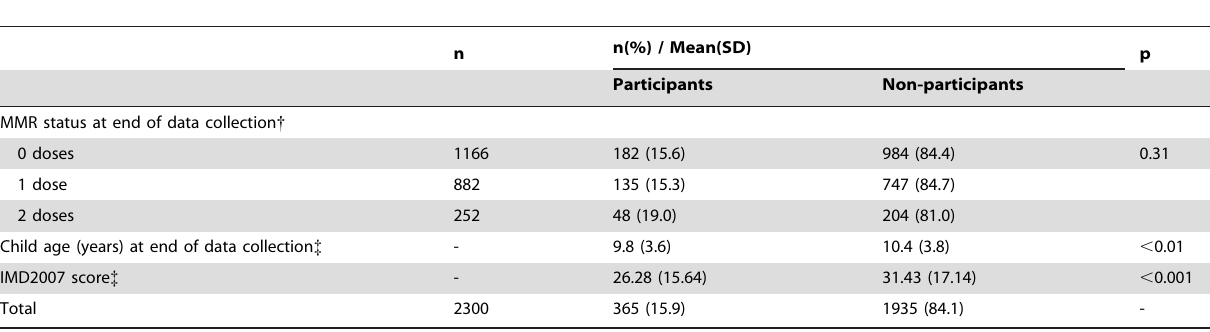
Table 1. Participation rates and representativeness.